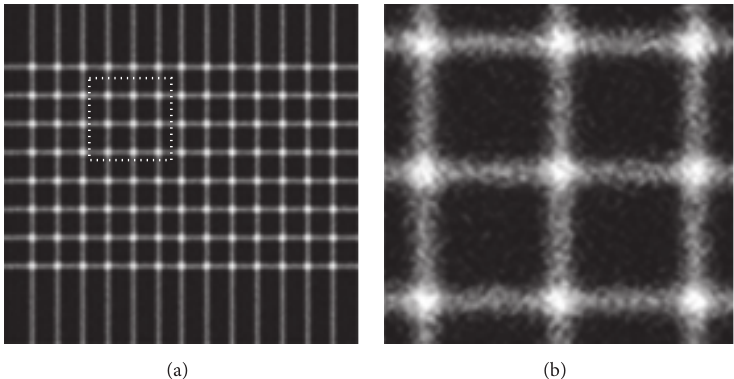
Figure 1: (a) Simulated undelayed image having an 8 × 13 MTV grid and (b) zoomed-in view of the highlighted region in